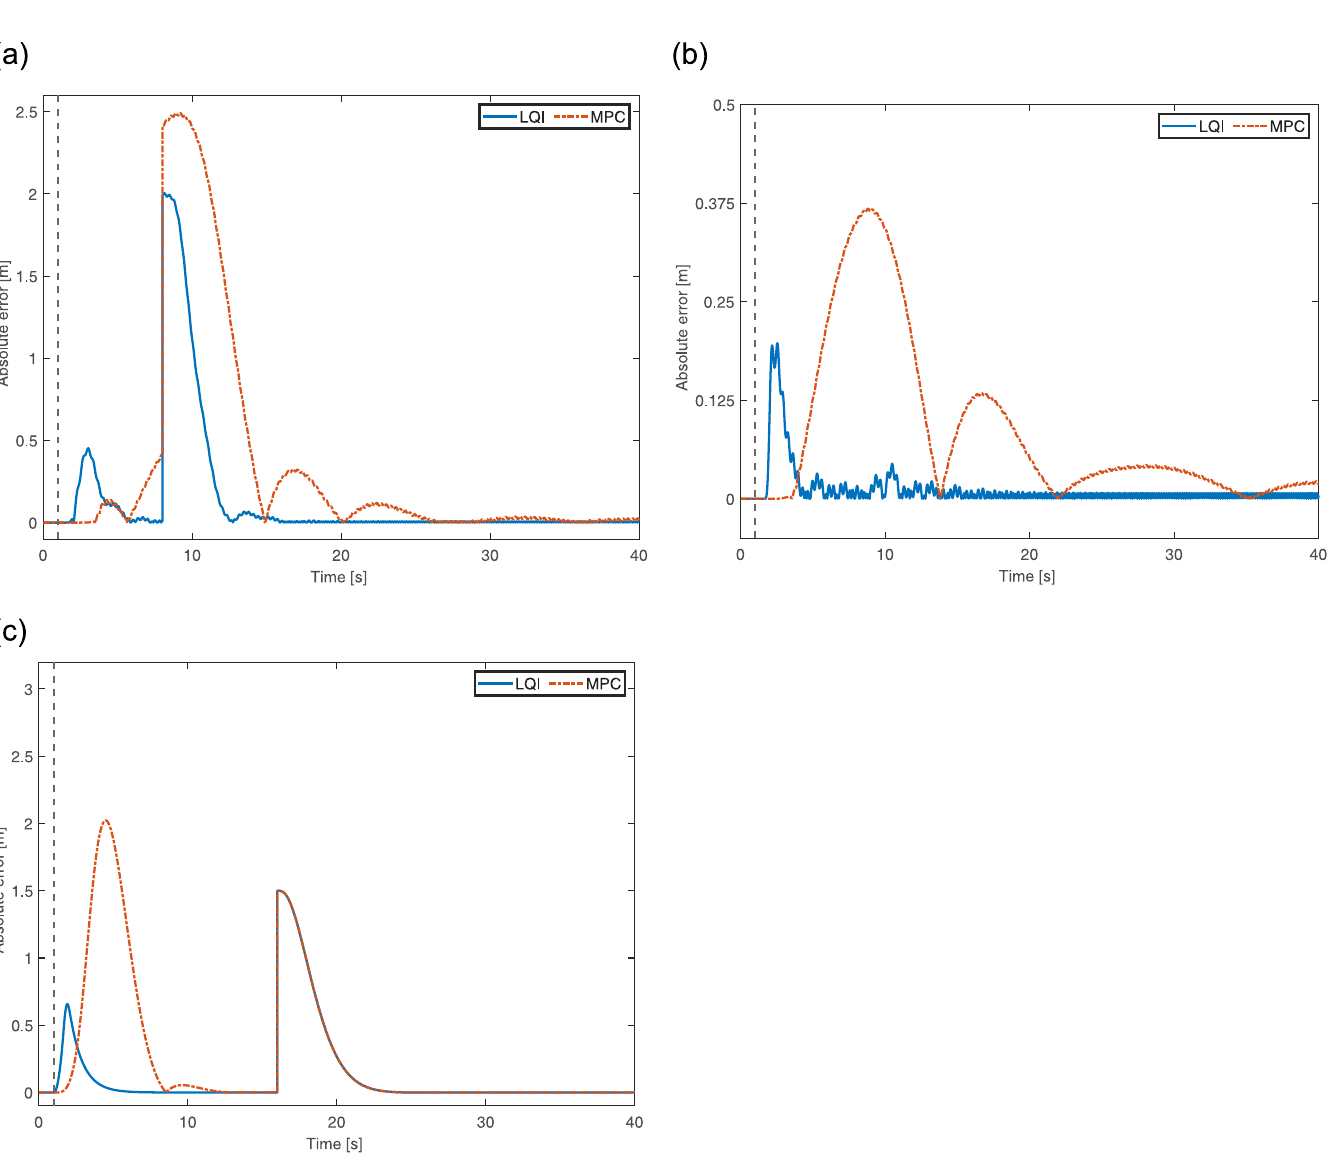
Fig 4. 3D position error of the quadrotor for One propeller failure. (a) Error in X-axis. (b) Error in Y-axis. (c) Error in